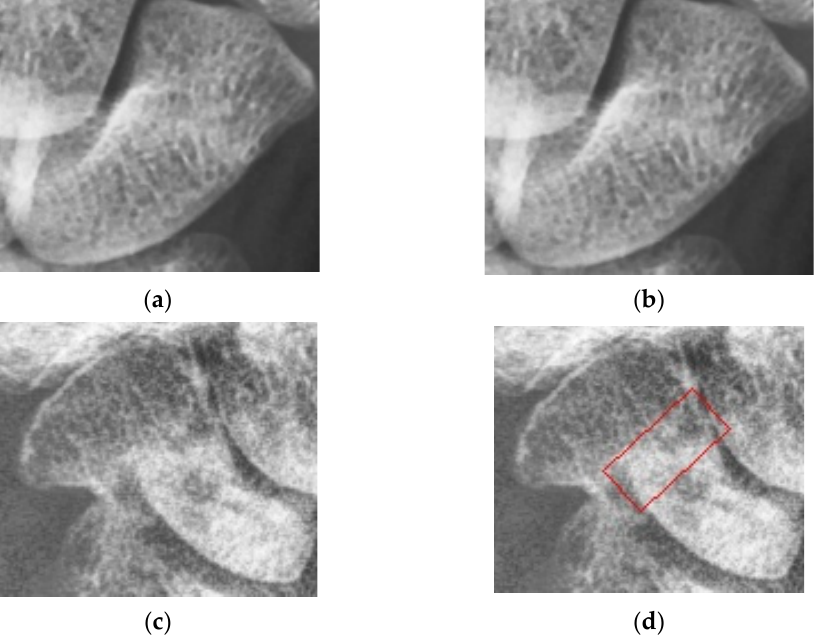
Figure 9. Two scaphoid cases with/without fractures. ( a ) Scaphoid case without fracture. ( b ) No fracture bounding box. ( c ) Scaphoid case with fracture. ( d ) Fracture bounding box. Table 1. The results of fracture detection of detected scaphoid.